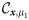
Construction of Elementary Growth States and Elementary Growth Modes.a) For fixed metabolite concentrations x and growth rate μ1, the balanced growth Eqs (22) and (24) define a cone Cx,μ1. Intersecting this cone with (23) defines a polytope Px,μ1 containing all balanced growth solutions. Its vertices are the EGSs at this growth rate and metabolite concentrations. b) Changing the growth rate from μ1 to μ2 changes the cone to Cx,μ2 and the polytope to Px,μ2, because (22) depends on μ. (A similar change would be seen if x had been changed.) c) The EGSs change continuously with μ (and also with x, not shown), but their support does not. The green lines, connecting the vertices in the different polytopes, together form the EGMs.